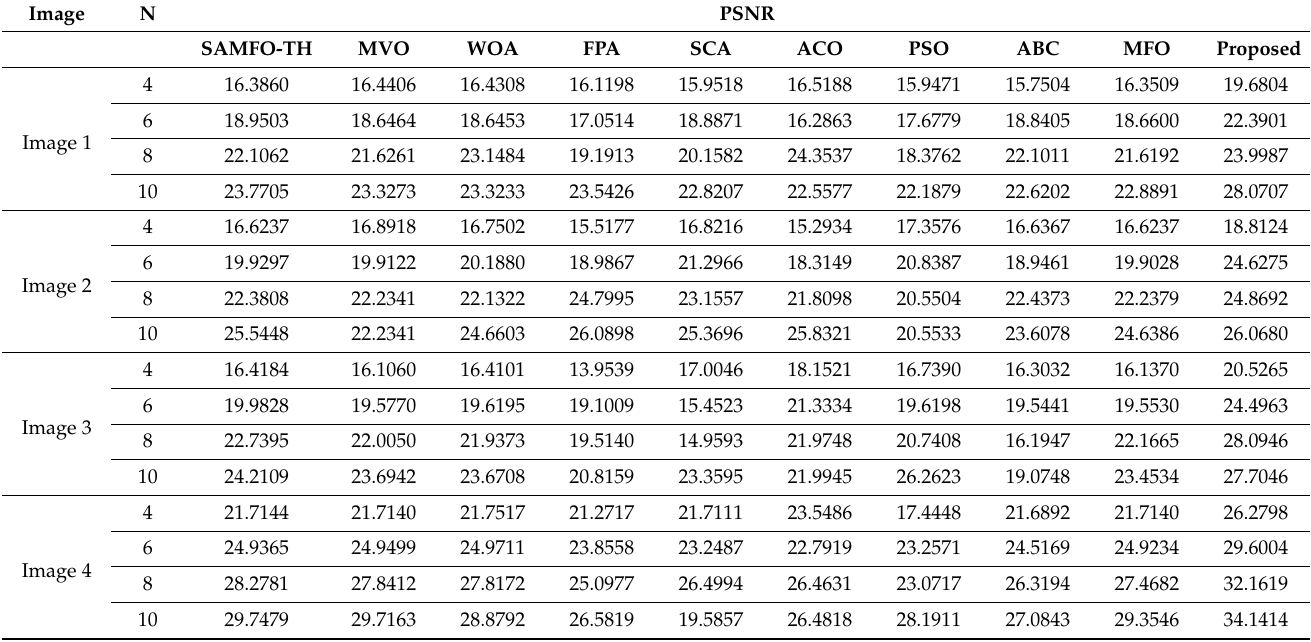
Table 9. Comparison of PSNR computed by SAMFO-TH, MVO, WOA, FPA, SCA, ACO, PSO, ABC, and MFOwith the proposed model using Otsu’s method with N = 4, 6, 8, and